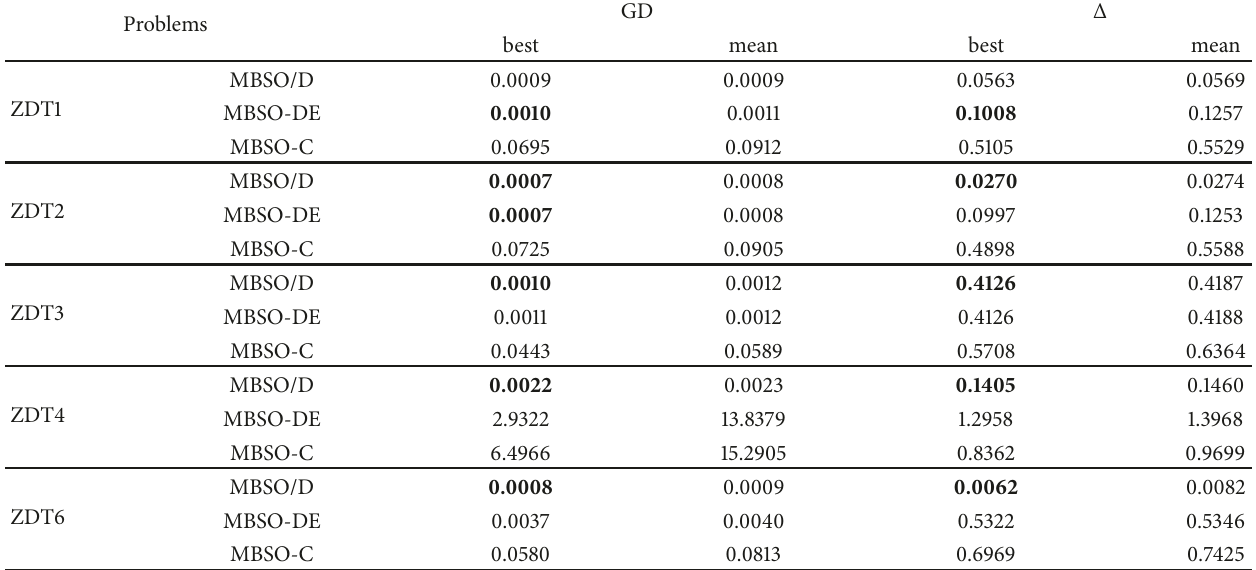
Table 2: GD and (cid:2) obtained by MBSO/D, MBSO-DE, and MBSO-C on five ZDT problems.